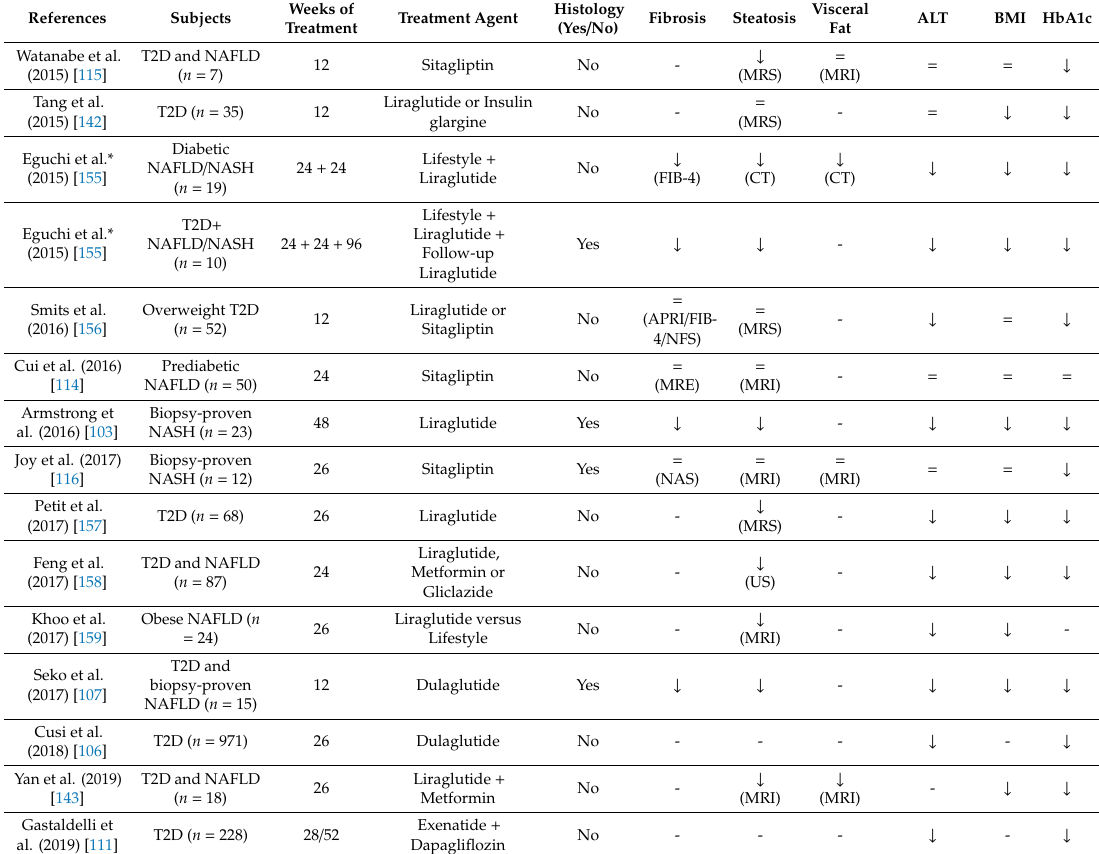
with various doses of liraglutide + metformin versus placebo or glimepiride [145]. Liraglutide decreased liver fat only in the 1.8mg / day + metformin group while changes in 0.6 and 1.2 mg / day liraglutide, placebo + metformin or glimepiride + metformin were not significantly di ff erent from baseline [145]. The LEAN (Liraglutide E ffi cacy and Action in Non-Alcoholic Steatohepatitis) trial is the largest